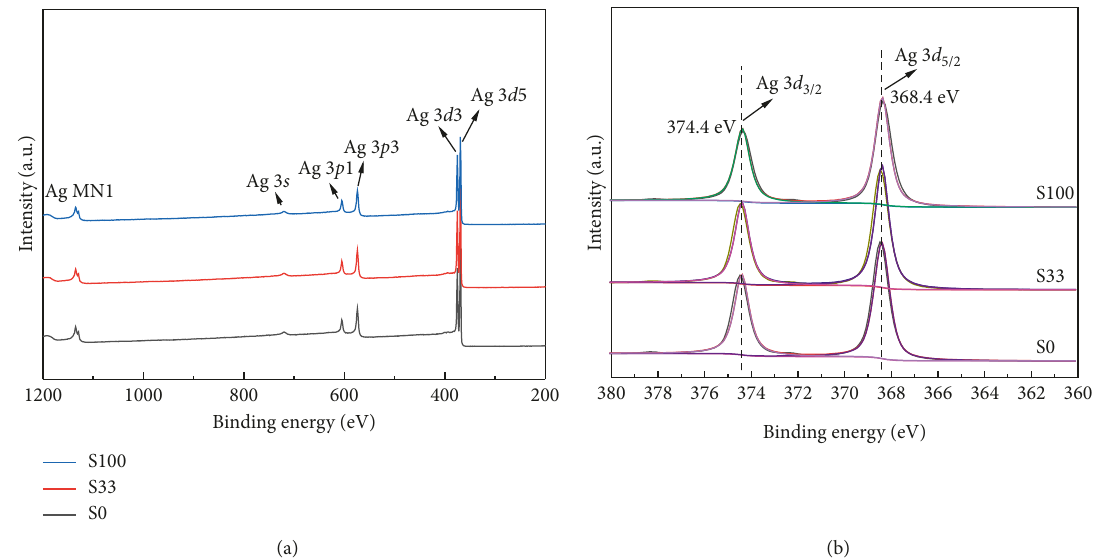
Figure 2: XPS spectra of S0, S33, and S100. (a) The wide-scan spectra of S100 sample. (b) Ag 3 d spectra.